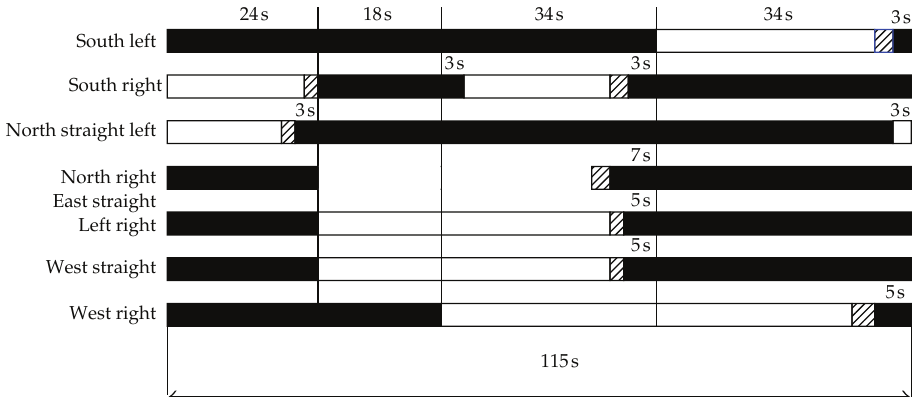
Figure 6: Distribution diagram of signal timing of Taiping North Road-Beijing East Road